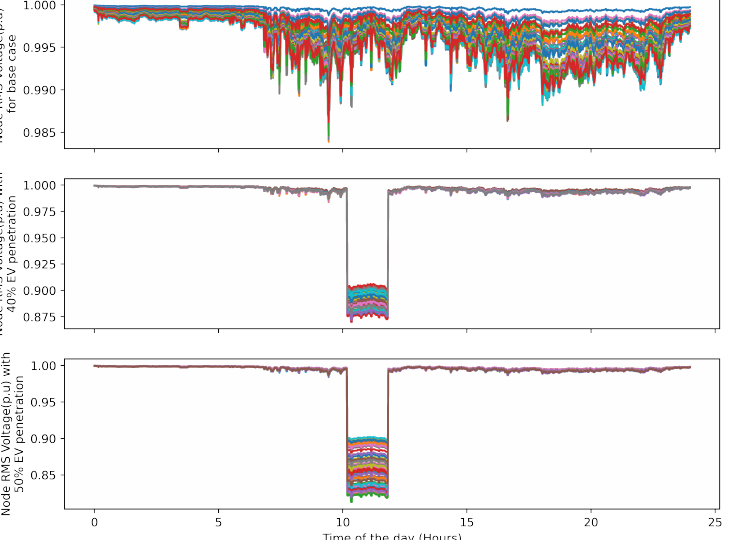
Figure 12. Comparison of RMS node voltages for different EV penetration scenarios. Each color corresponds to a node in the